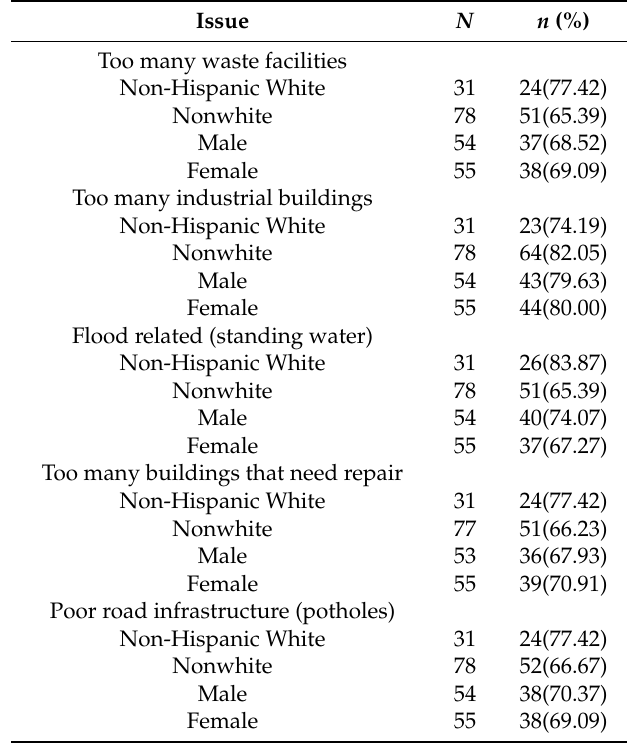
Table 3. Identified problems in neighborhood stratified by race, and